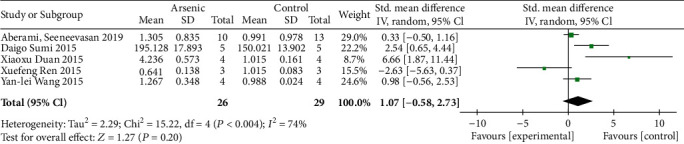
Meta-analysis of the effect of arsenic on the GCLM of r-GCS subunits in vivo. The forest plot shows the effect of arsenic treatment on GSH in the experiment and control group. SMD: standardized mean difference; IV: independent variable; 95% CI: 95% confidence interval; SD: standard deviation. The P value of the overall test effect is 0.20; when P <0.05, the difference was considered statistically significant.